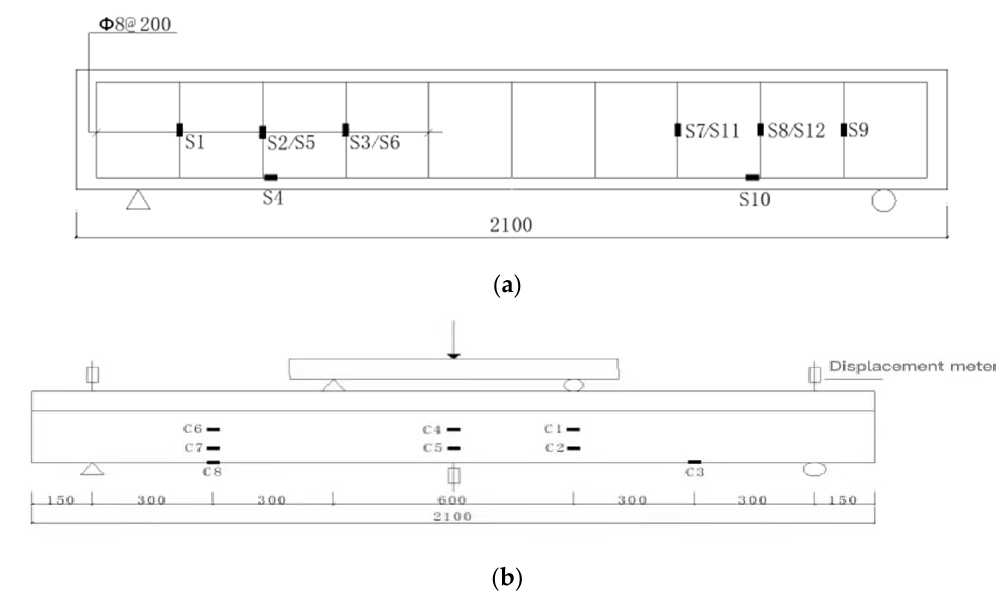
Figure 1. Rebar and concrete strain gauge layout. ( a ) Rebar strain guage layout. ( b ) Concrete strain gauge layout.